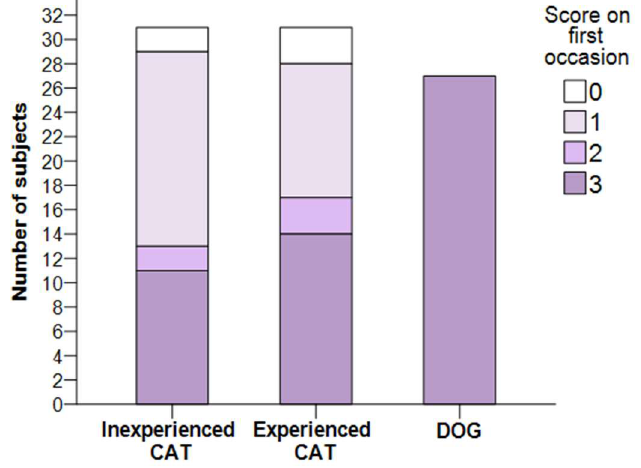
Figure 3. Scores received by dogs and cats (IE and E) on the first occasion in the habituation test. All dogs passed the test on the first occasion.